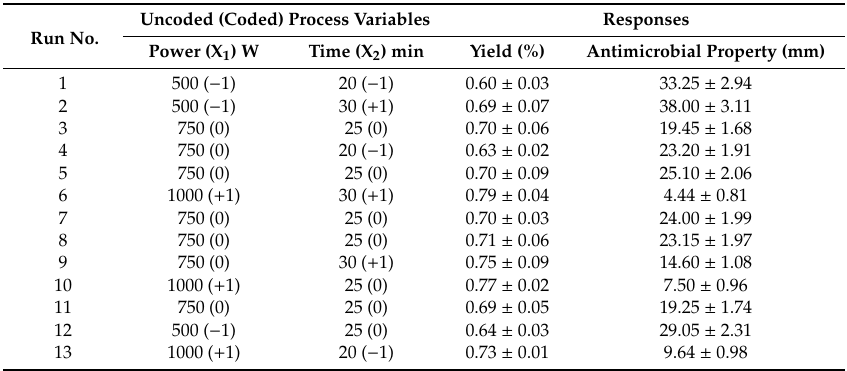
Table 1. Central composite design (CCD) with observed responses for essential oil.